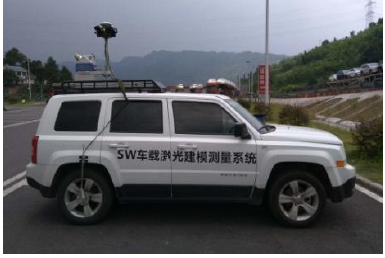
Figure 1. Vehicle-borne Laser Scanning